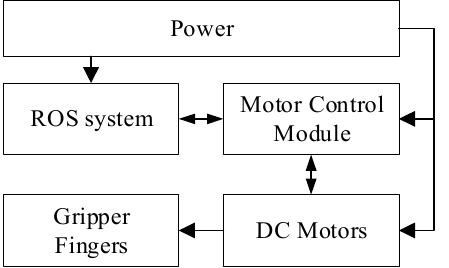
Figure 3. The control system of the proposed universal